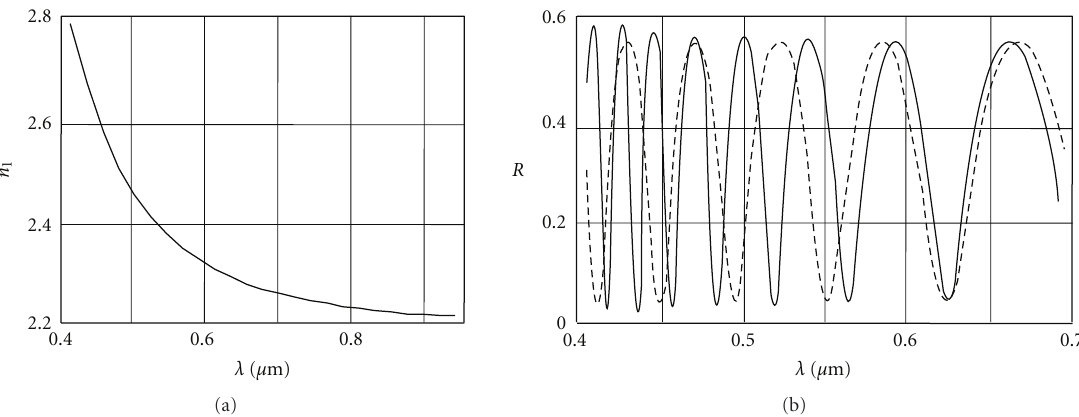
Figure 6: (a) Experimental curve n 1 ( λ ) for an oxide film TiO 2 [27] and (b) the reflectance spectrum R ( λ ) calculated for such a film (solid line) and for a nondispersive film with n 1 = 2 . 3 (dashed line) both deposited on a titanium substrate.